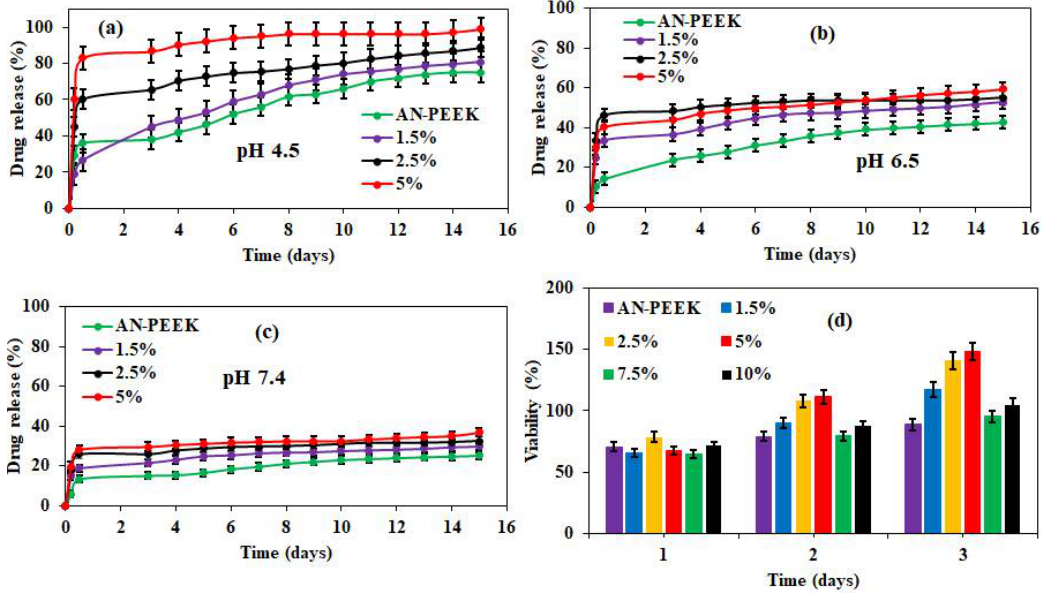
Figure 4. Drug release results of DOX-loaded AN-PEEK and AN-PEEK / f-CNOs thin films: ( a ) pH 4.5, ( b ) pH 6.5, and ( c ) pH 7.4 at 37 °C in DMEM solution. ( d ) Cell viability of thin films.